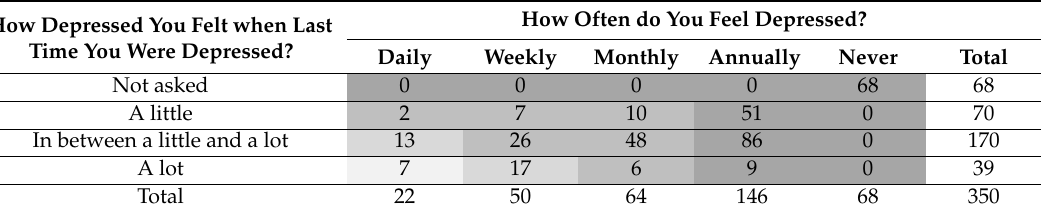
Table 7. Cross-tabulation (a ff ect / depression domain).